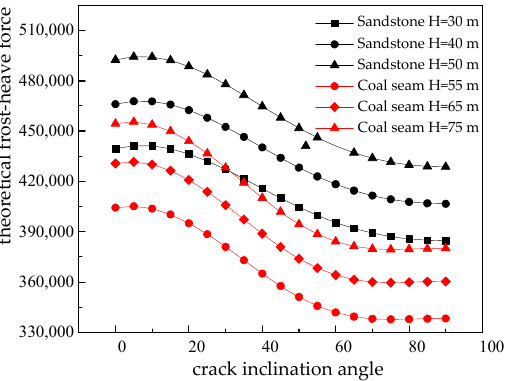
Figure 6. Relationship between theoretical frost heaving force and crack inclination angle.